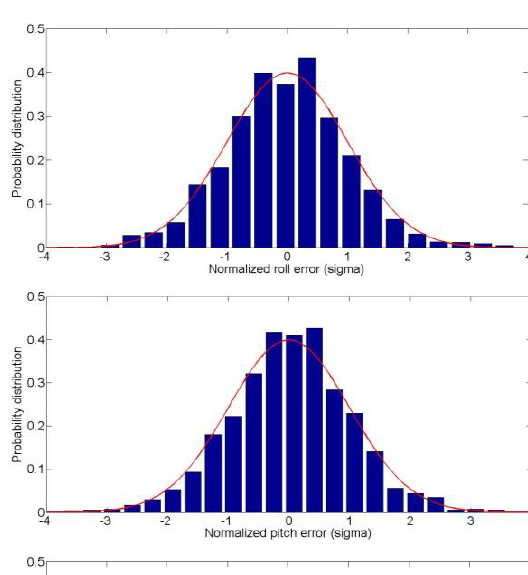
Figure 9: Distribution of the boresight errors (roll/pitch/heading)